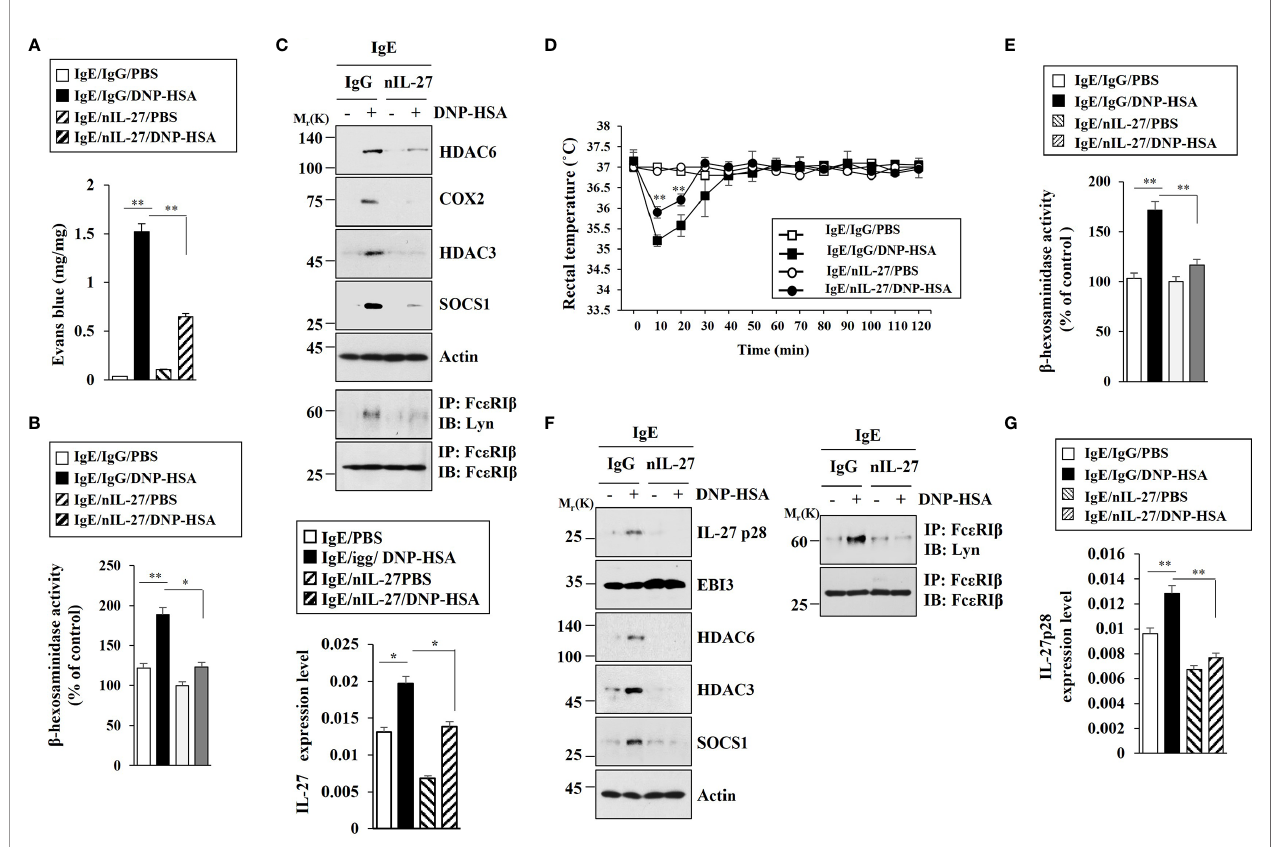
FIGURE 6 | IL-27 mediates both PCA and PSA. (A) BALB/C mice were given an intradermal injection of IgE (0.5 m g/kg) and an intravenous injection of the indicated antibody (each at 20 µg/kg). The next day, BALB/C mice were intravenously injected with PBS or DNP-HSA (250 m g/kg) along with 2% (v/v) Evans blue solution. Each experimental group comprised four BALB/C mice. ** p <0.01. (B) The b -hexosaminidase activity assays using ear tissue lysates were performed (n=4). * p <0.05; ** p <0.01. Average values of three independent experiments are shown. (C) Immunoblot and immunoprecipitation employing ear tissue lysates were performed (n=4). Representative blots of three independent experiments are shown. Ear tissue lysates were also subjected to qRT-PCR (lower). * p <0.05. (D) BALB/C mice were given an intravenous injection of DNP-speci fi c IgE (0.5 µg/kg) along with the indicated antibody (each at 20 µg/kg). The next day, BALB/C mice were given an intravenous injection with DNP-HSA (250 m g/kg), and the rectal temperatures were measured. Each experimental group comprised four mice. ** p <0.01, compared with IgE/IgG/ DNP-HSA. (E) The b -hexosaminidase activity assays employing lung tissue lysates were performed (n=4). ** p <0.01. Average values of three independent experiments are shown. (F) Immunoblot and immunoprecipitation employing lung tissue lysates were performed (n=4). Representative blots of three independent experiments are shown. (G) QRT-PCR analysis employing lung tissue lysates was performed. ** p <0.01. Average values of three independent experiments are